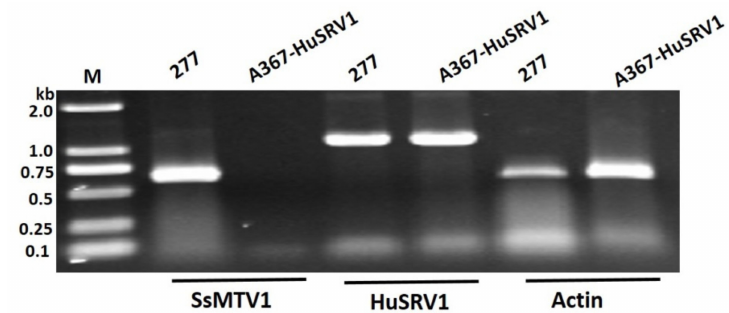
Figure 2. RT-PCR amplification analysis of strain 277 and transfected A367-HuSRV1. The results indicate that strain 277 harbored two viruses, while the transfected strain A367-HuSRV1 contains HuSRV1 alone. The actin gene was served as a control. RT-PCR was carried out with virus-specific primers (Table S1) for the two viruses (HuSRV1, or SsMTV1), with cDNA obtained from the total RNA extracted from strain 277 and transfected strain A367-HuSRV1. Lane M means molecular weight marker DL2000 (Takara, Dalian, China).